Question: Describe this figure in one sentence.
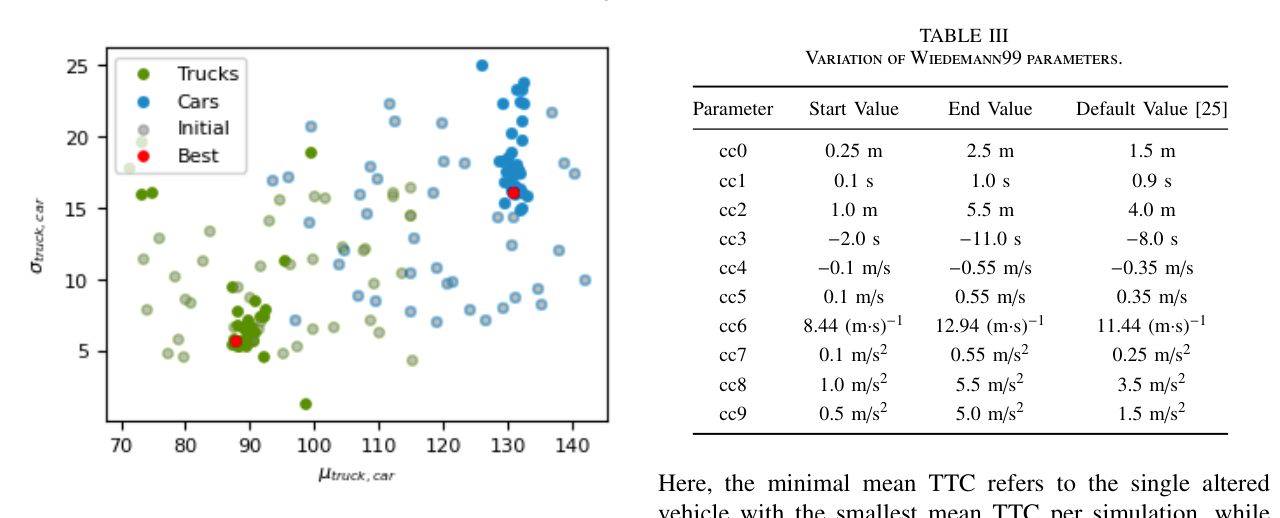
Answer: Comparison of the respective 100 resulting µ and σ, of each individual estimation run. The parameters for the truck type are depicted in green and car type in blue. Further, initial guesses for each estimation run are shown in gray.